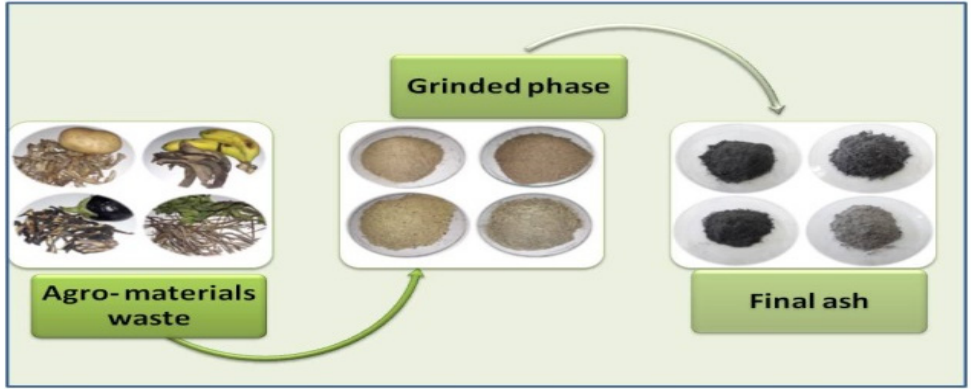
Figure 1. Method for preparation of